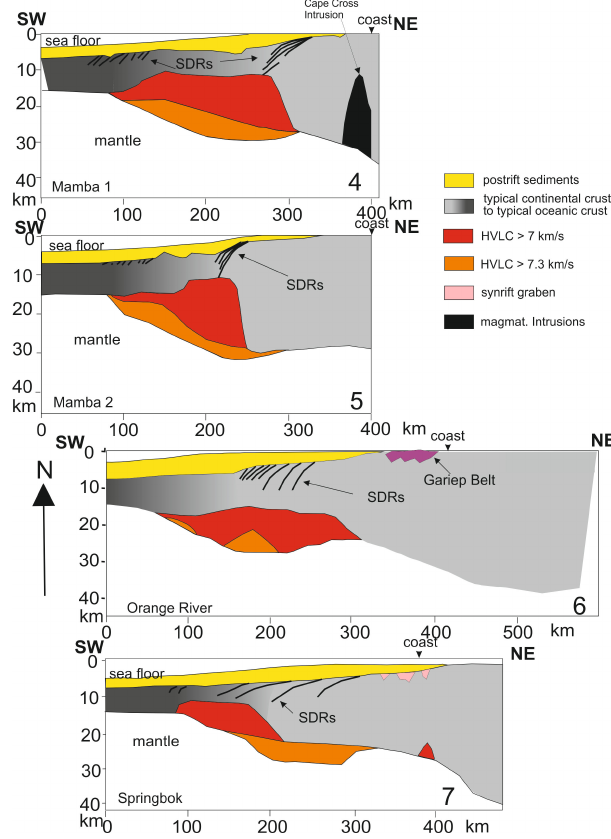
Figure 8. Interpretation of the crustal-scale lines 4–7 from north (top) to south (bottom) along the South African margin with empha- sis on the HVLC. HVLC with P -wave velocities above 7.0kms − 1 is indicated in red, HVLC exceeding 7.3kms − 1 is shown in or- ange. Line 4 (Mamba 1) and line 5 (Mamba 2) are modified after Bauer et al. (2000), line 6 (Orange River mouth) is modified after Schinkel (2006) and line 7 (Springbok) is modified after Hirsch et al. (2009). The shape and distribution of SDRs as interpreted from coincident seismic reflection data are indicated as black lines. Same scale as in Fig.